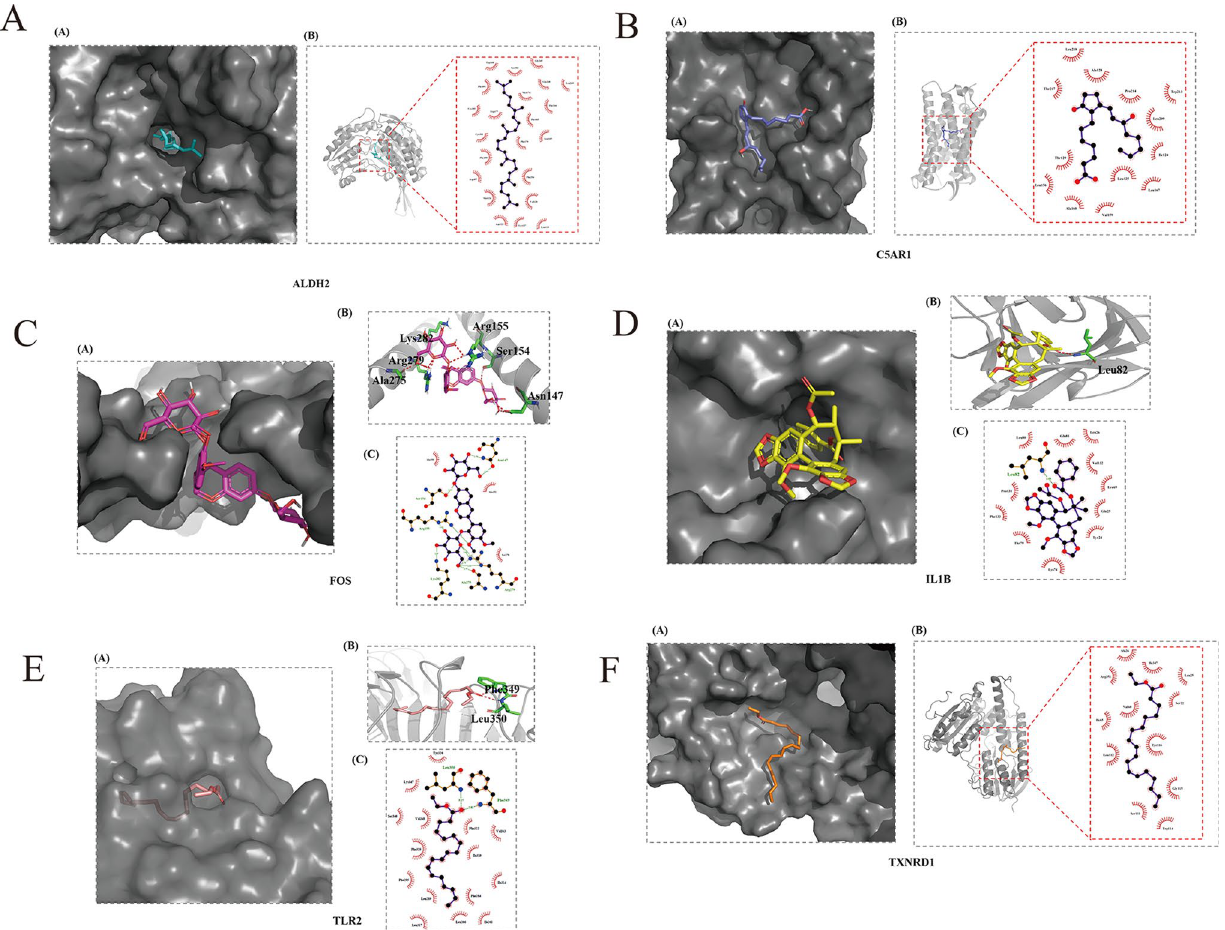
Figure 9. The complex model of ligand and receptor as well as their interactions. The figure is drawn using the SYBYL-X 2.0 software (Tripos, St. Louis, MO). ( A ) The best combination with ALDH2 is Supraene. ( B ) The best combination with C5AR1 is prostaglandin B1. ( C ) The best combination with c-Fos is isomucronulatol-7,2’-di- O-glucosiole. ( D ) The best combination with IL1 beta is angusifolin B. ( E ) The best combination with TLR2 is Linolenic acid ethyl ester. ( F ) The best combination with TRXR1 is Mandenol.